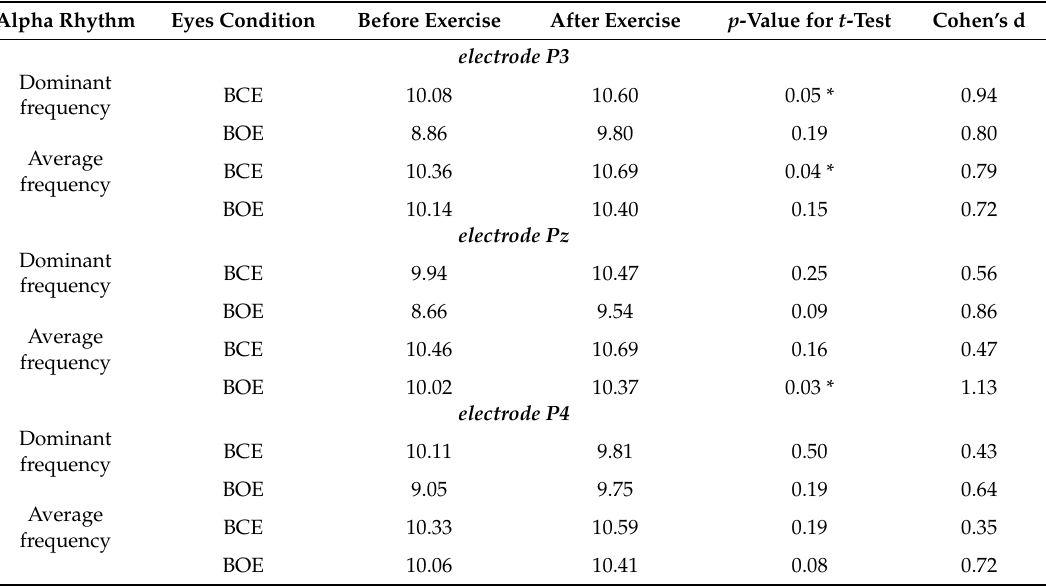
Table 5. Dynamics of alpha rhythm before and after